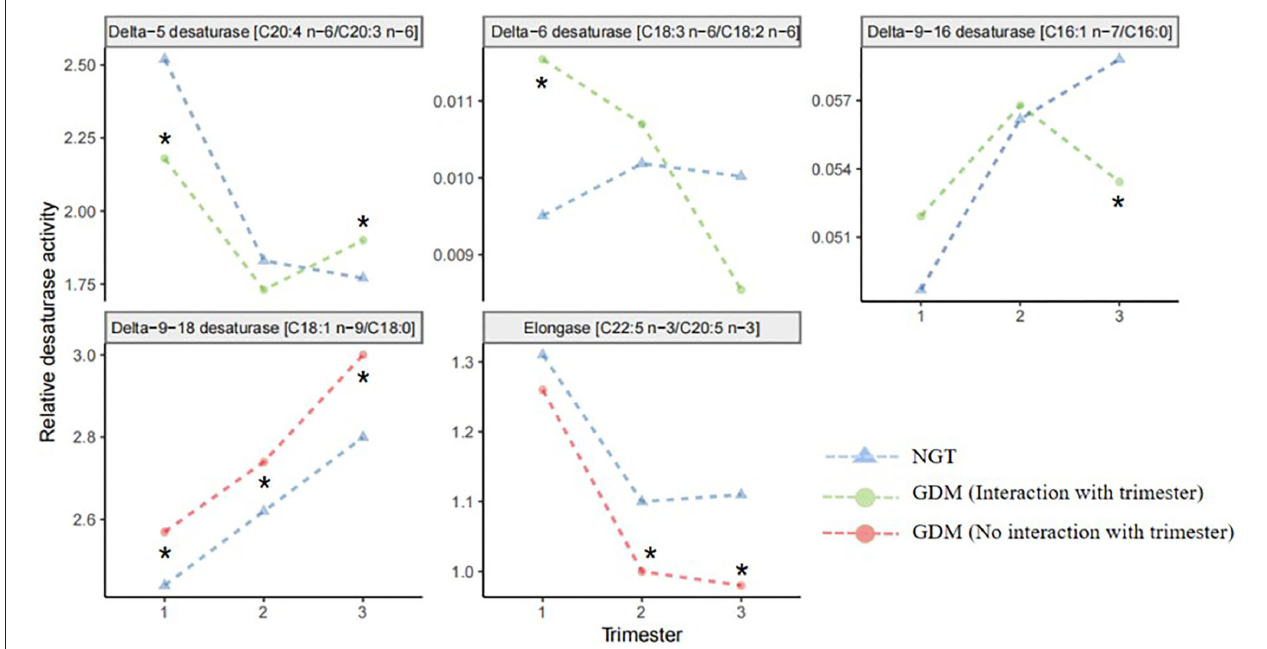
FIGURE 2 | Line plots of the robust fitted effects of GDM across the pregnancy. Circles represent the fitted effects in GDM, and triangles represent NGT. When the line is orange, there is no significant interaction with trimester. When the line is green, the effect changes across the trimester. Fatty acid desaturase activities were entered into the mixed model as the response variable; GDM and trimester were assigned as fixed effects; the individual was assigned as a random effect. NGT, normal glucose tolerance; GDM, gestational diabetes mellitus. *Significant difference between GDM and